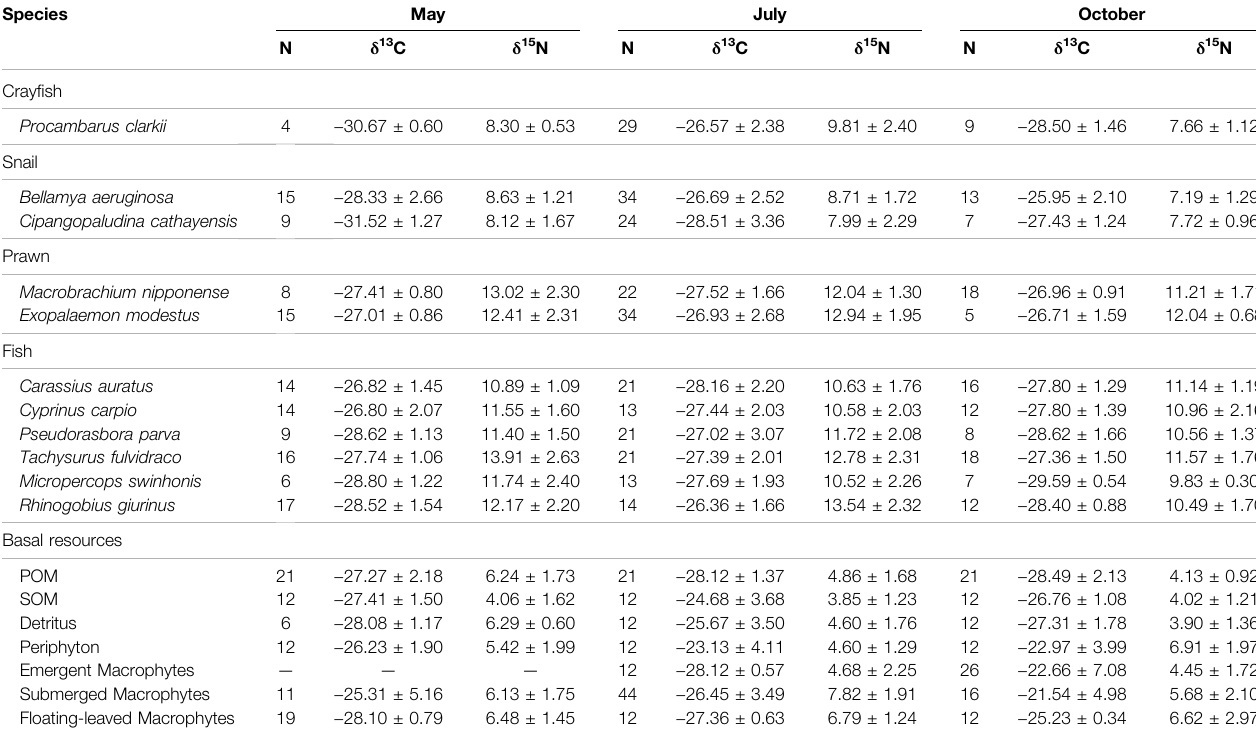
TABLE 1 | Mean (± 1 SD) values of stable isotope carbon ( δ 13 C) and nitrogen ( δ 15 N) for cray fi sh, snails, prawns, fi shes and basal resources sampled in May 2019 (rising water), July2019(highwater)andOctober2019(fallingwater)fromPoyangLakewetland.Samplesarefromcatchesofgillnetsandtrapnets;onlycommon fi shspecies (IRI > 500) were analyzed. POM = suspended particular organic matter, SOM = organic matter in surface sediments.